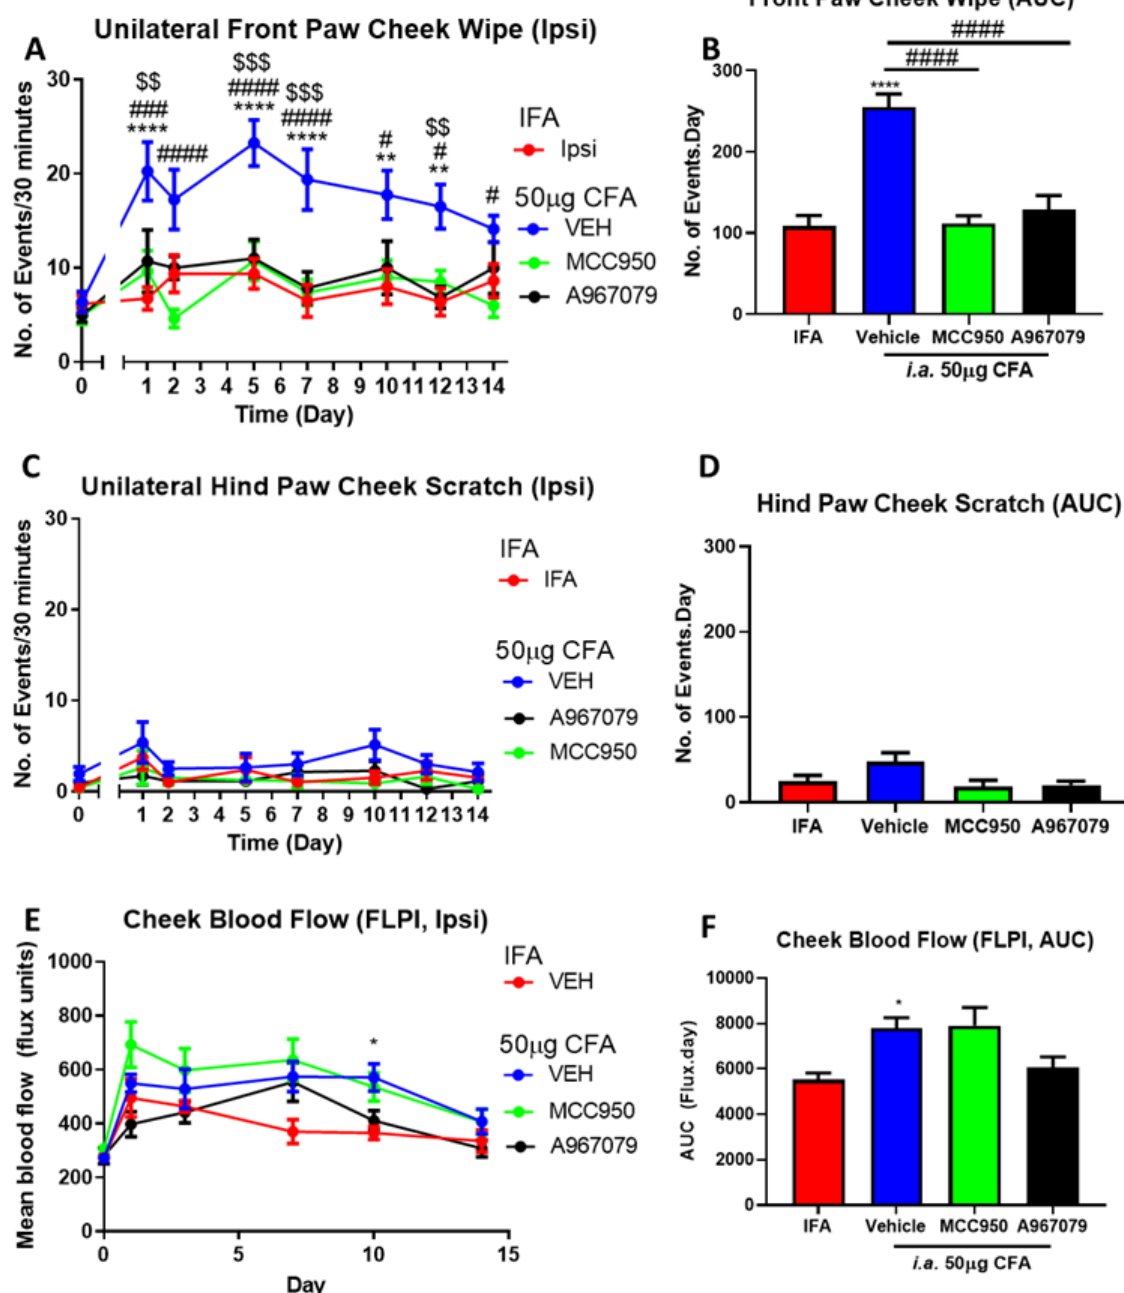
Figure 4. Repeated TRPA1 antagonist (A967079) and NLRP3 antagonist (MCC950) over 14 days significantly inhibited CFA-mediated pain-like behaviours and have differential effects on cheek blood flow. The numbers of ipsilateral ( A ) unilateral front paw cheek wipe and ( C ) hind paw cheek scratch observed over 30 min. The changes in cheek blood flow was observed at various timepoints ( E ). The AUC for ( B ) front paw cheek wipe, ( D ) hind paw cheek scratch, and ( F ) cheek blood flow. Data represent mean ± SEM, n = 7 − 8 animals per group. Data analysed by two-way repeated measures ANOVA ( A , C , E ) or one-way ANOVA ( B , D , F ) with Bonferroni’s post hoc test. * p < 0.05, ** p < 0.01, **** p < 0.0001 IFA vs. CFA, # p < 0.05, ### p < 0.001, #### p < 0.0001 CFA/VEH vs. CFA/MCC950 in the timepoint reading or between indicated groups, $$ p < 0.01, $$$ p < 0.001 between CFA/VEH vs. CFA/A967079 in the timepoint